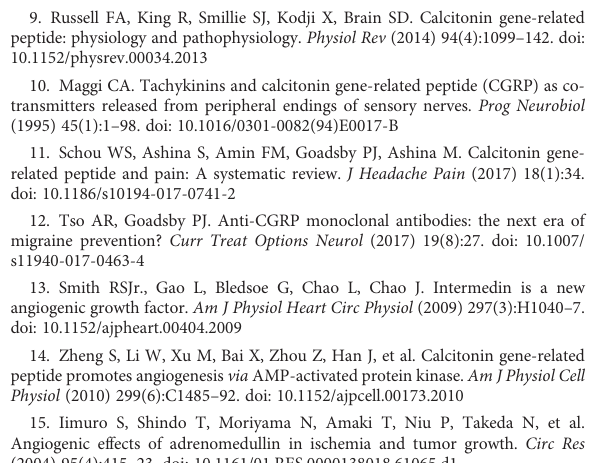
SUPPLEMENTARY FIGURE 1 Identi fi cation of wild-type and Adm2 loxP/loxP transgenic mice. PCR ampli fi cation was used to detect the wild-type and transgene sequences. The 450- and 350-basepair PCR products indicated the presence of transgene and wild-type sequences, respectively. Mouse tail DNA samples in lanes 2, 3, 8, and 10 were from homozygous mice whereas those in lanes 4-7 were from wild-type animals. Samples in lanes 9 and 11-15 were from heterozygous animals. The red horizontal bar indicates the position of the 500-bp size marker. SUPPLEMENTARY FIGURE 2 Expression of the wild-type Adm2 transcript in the ovary and kidney tissues. Reverse transcription-polymerase chain reaction (RT-PCR) was usedtodetectthepresenceofwild-type Adm2 mRNAintheovary(O)and kidney (K) of wild-type (+/+), heterozygous (+/-), and homozygous (-/-) animals. The 535-basepair PCR product indicates the presence of the wild-typ e Adm2 mRNA. The primer set sequences used to detect the wild-type Adm2 transcript are 5 ’ -GAC TGA GGC ACT CCA GAC CCA GAG A-3 ’ and 5 ’ -TGT CGG TGC AGA TTC TAC AGC CTA GAT-3 ’ . Positions of the Adm2 and Gapdh cDNA products are indicated by